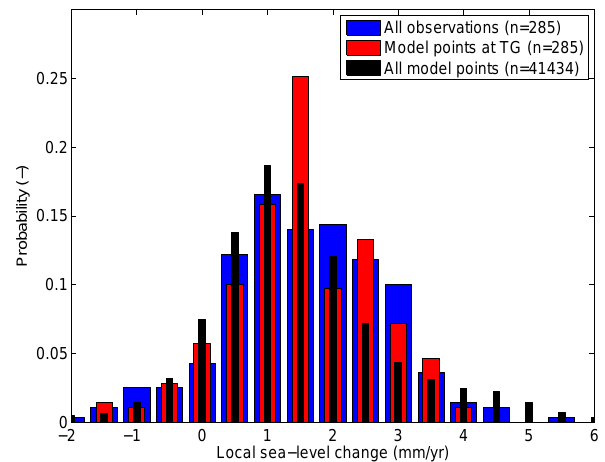
Figure 10. Histogram of the tide gauge values (blue), associated model points (red), and all ocean grid points (black). Bin width = 0.5mmyr − 1 . Percentage of each series below − 2mmyr − 1 is 5.8, 4.3 and 2.4%, respectively. Percentage above 6 mmyr − 1 is 0.4, 0 and 0.3%,